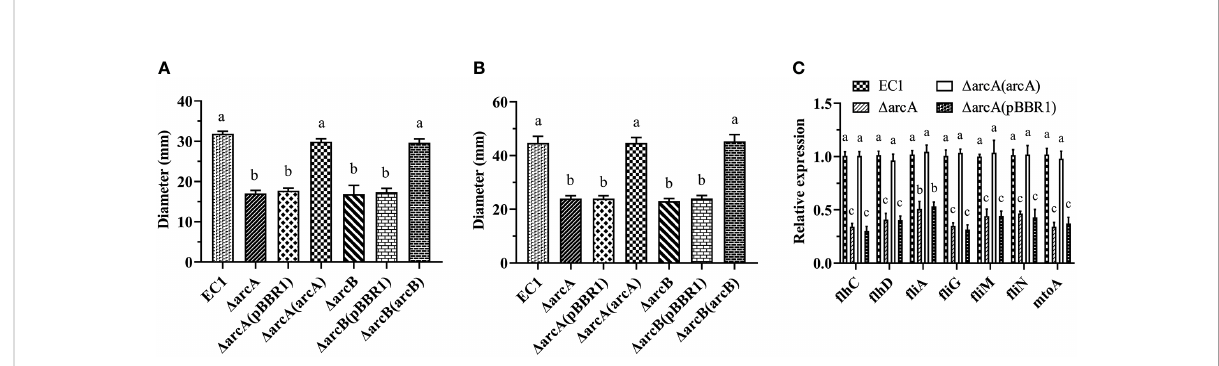
FIGURE 3 Deletion mutants D arcA and D arcB showed decreased bacterial swimming (A) and swarming (B) motility compared with wild-type strain EC1 and their complementary strains. The overnight bacterial culture (1 m l) was spotted on the center of the bacterial motility plates and incubated at 28 °C for 18 h (swarming motility) and 14 h (swimming motility) before measurements. (C) Gene expression of fl agellar genes fl hC , fl hD , fl iA , fl iG , fl iM , fl iN and motA in strains D arcA and D arcA(pBBR1). Each experiment was repeated three times in triplicate. The statistical analysis was performed on each group of data, and signi fi cantly different values (analysis of variance, p < 0.05) are indicated by different letters.